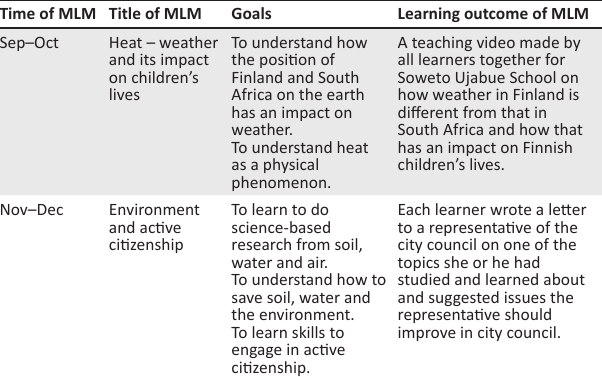
TABLE 1: The multidisciplinary learning modules of the study.